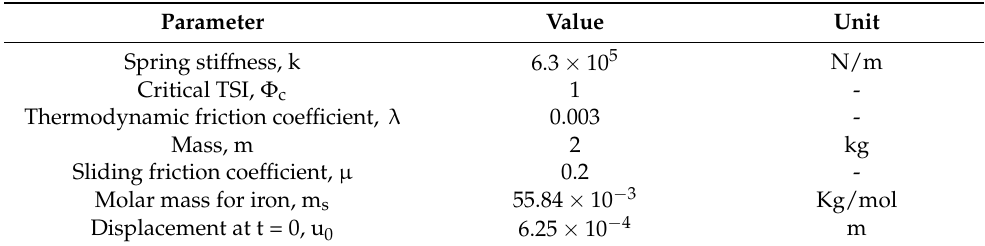
Table 1. List of Parameters used to solve the proposed model and the Newtonian mechanics equation. Parameter Value Unit Spring stiffness, k 6.3 × 10 5 N/m Critical TSI, Φ c 1 - Thermodynamic friction coefficient, λ 0.003 - Mass, m 2 kg Sliding friction coefficient, µ 0.2 - Molar mass for iron, m s 55.84 × 10 − 3 Kg/mol Displacement at t = 0, u 0 6.25 × 10 − 4 m Newtonian mechanics equilibrium Equation (35) and unified mechanics equilibrium Equation (39) were solved for an initial excitation. Results are plotted in Figure 3 through Figure 6 for the input parameters given in Table 1. The solution of the equation of motion in unified mechanics theory and Newton’s law for damped oscillation of the mass are shown in Figure 3 for displacement and Figure 4 for velocity, respectively. It can be readily noticed